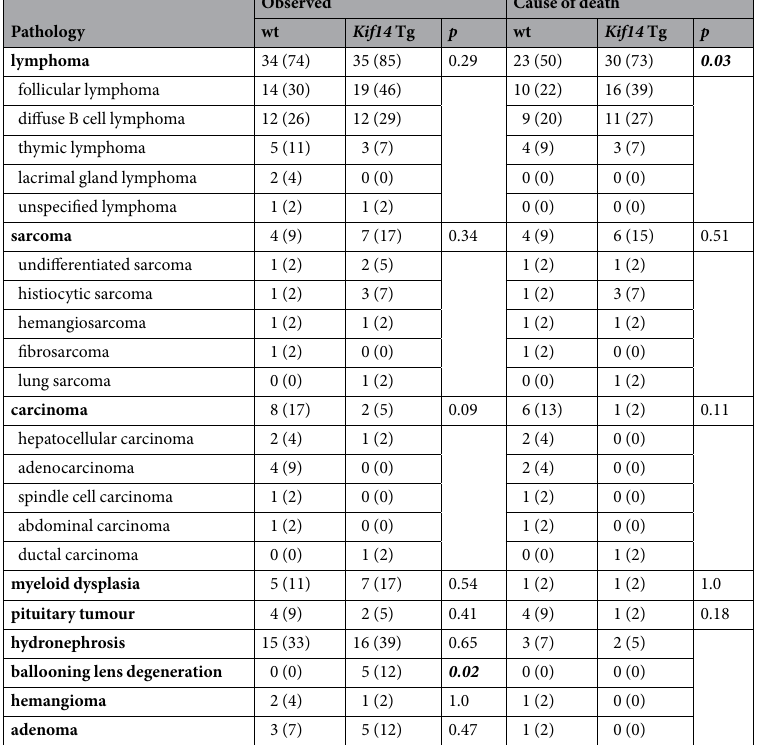
Table 1. Spectrum of pathological observations in Kif14 transgenic (Tg) mice versus wild-type (wt) littermates. Data are stratified into animals in which a pathology was observed, and the subset of animals in which that pathology was the cause of death. Note that some animals exhibited multiple pathologies. Number of animals and (% of total necropsied) per genotype indicated ( N = 46 for wt, 41 for Kif14 Tg). Fisher’s exact test p -values for comparing genotypes shown; significant differences are bold and